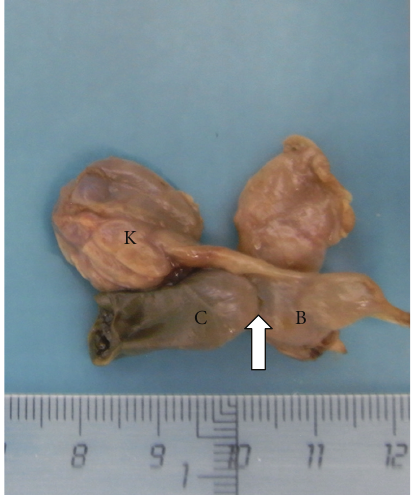
Figure 5: Cloacal septation anomaly. The sigmoid colon (C) ends in the bladder (B) (arrow). The ureters are short and connect with two dysplastic kidneys